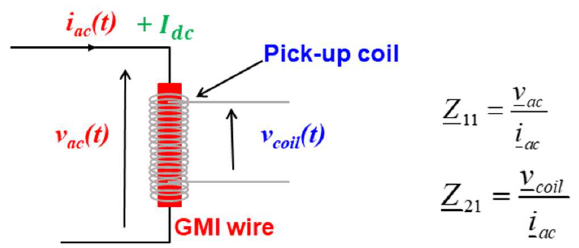
Figure 1. Principle of the diagonal and off-diagonal GMI sensor.